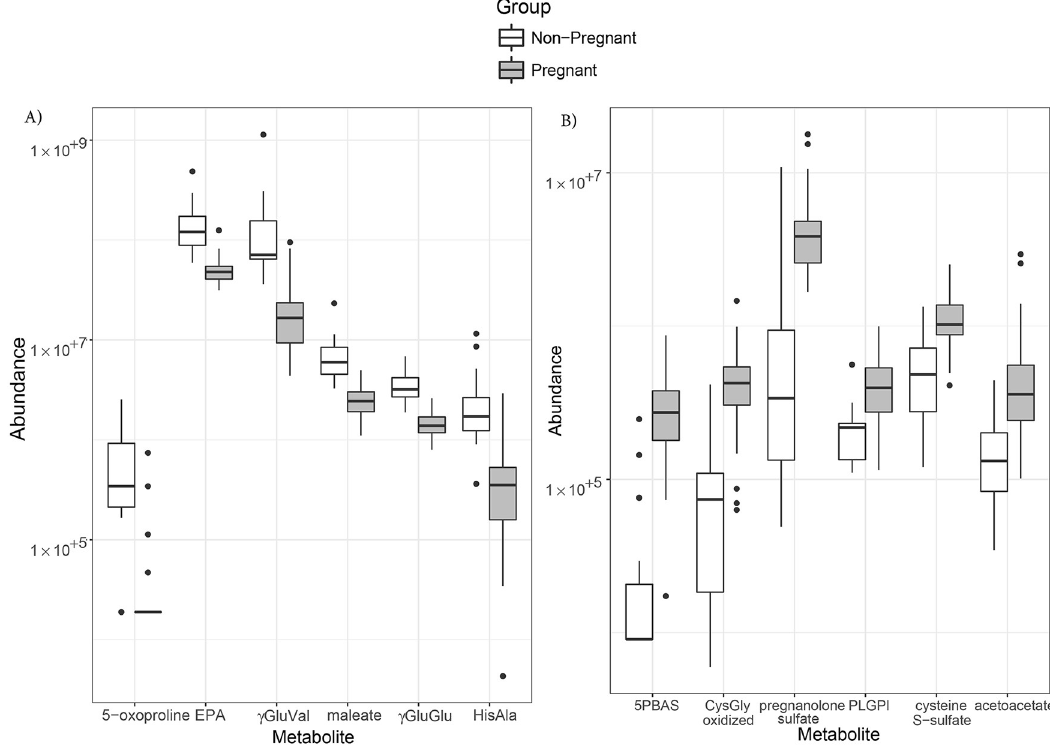
Fig 2. Boxplots of small-molecule abundance as a function of pregnancy status. The distribution of metabolites with increased (A) or decreased (B) abundance are shown using boxplots; the thick lines represent the medians, the boxes represent inter-quartile ranges, and the whiskers extend to the minimum/maximum values if not more than 1.5 times the interquartile range. EPA = eicosapentaenoate; γ GluVal = γ -glutamyl valine; γ GluGlu = γ -glutamyl glutamate; HisAla = histidylalanine; 5PBAS = 5 α -pregnan- 3 β ,20 α -diolmonosulfate; PLGPI = palmitoyl-linoleoyl-glycerophosphoinositol; CysGly, oxidized = glycine-cysteine-(SS)-cysteine- glycine.